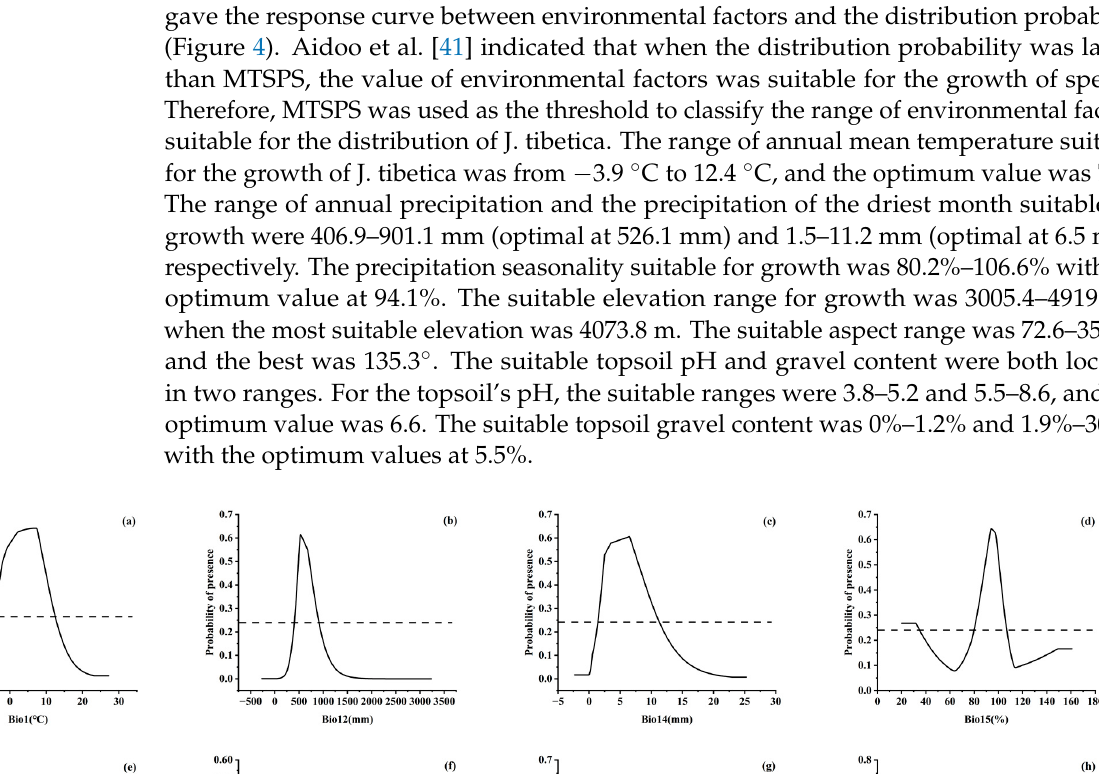
Table 3. The contribution rate and value of gain of climatic variables.